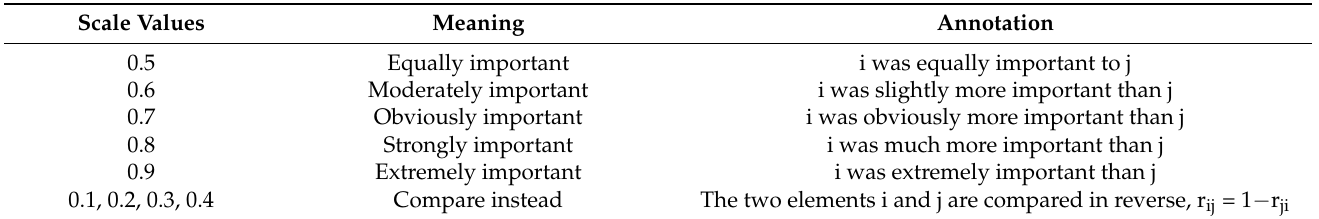
Table 2. Importance scale.